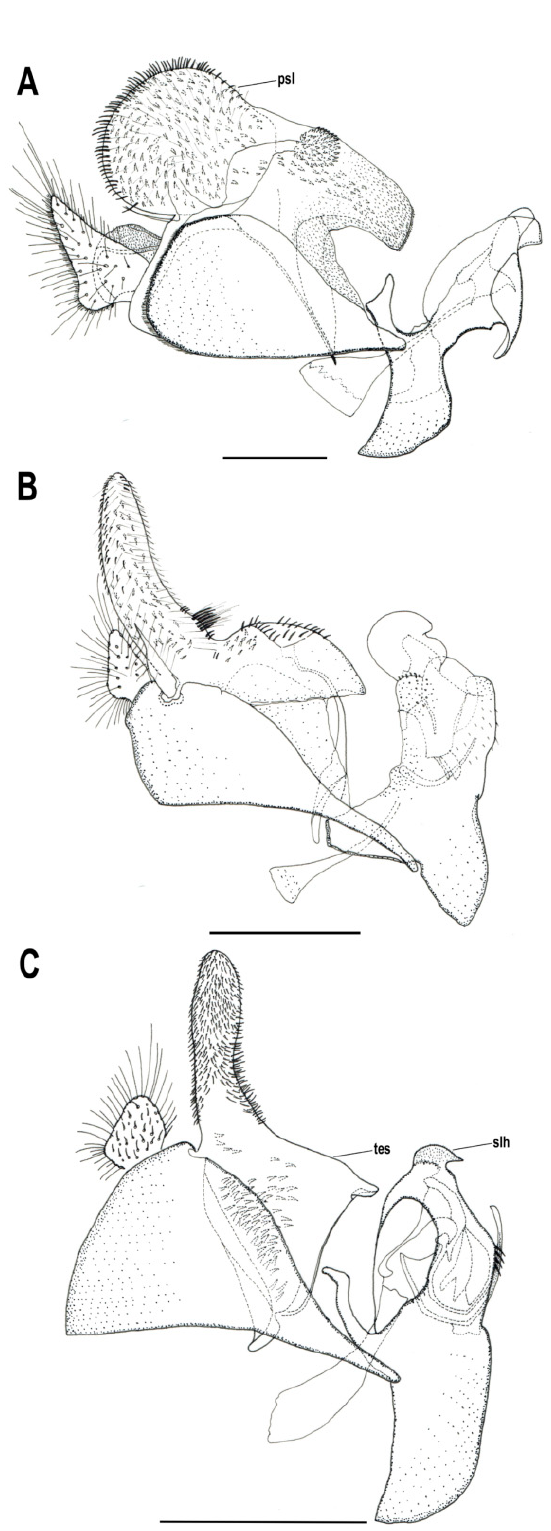
Figure 2. Meromacrus male genitalia, lateral view. ( A ): M. cactorum sp. nov., scale bar = 0.45 mm. ( B ): Meromacrus ruficrus , scale bar = 0.78 mm. ( C ): Meromacrus yucatense sp. nov., scale bar = 1 mm. Legend: psl, posterior surstylar lobe; tes, triangular expansion of surstylus; slh, superior lobe of hypandrium.